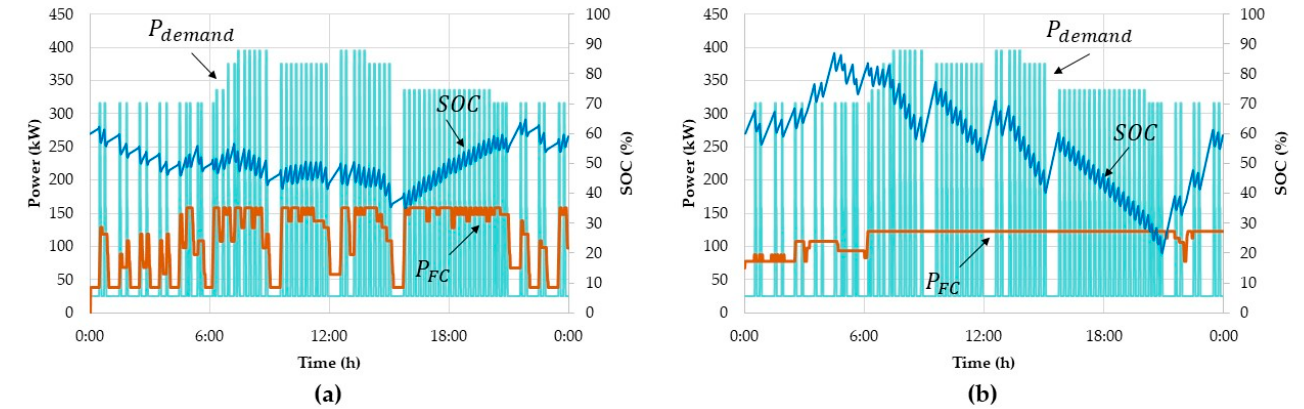
Figure 5. Non-health conscious daily optimal operation of the ferry during the ( a ) first month and ( b ) last month of operation. Light blue lines represent the ferry power demand, orange lines represent the PEMFC output power, the blue lines the SOC of LFP battery.